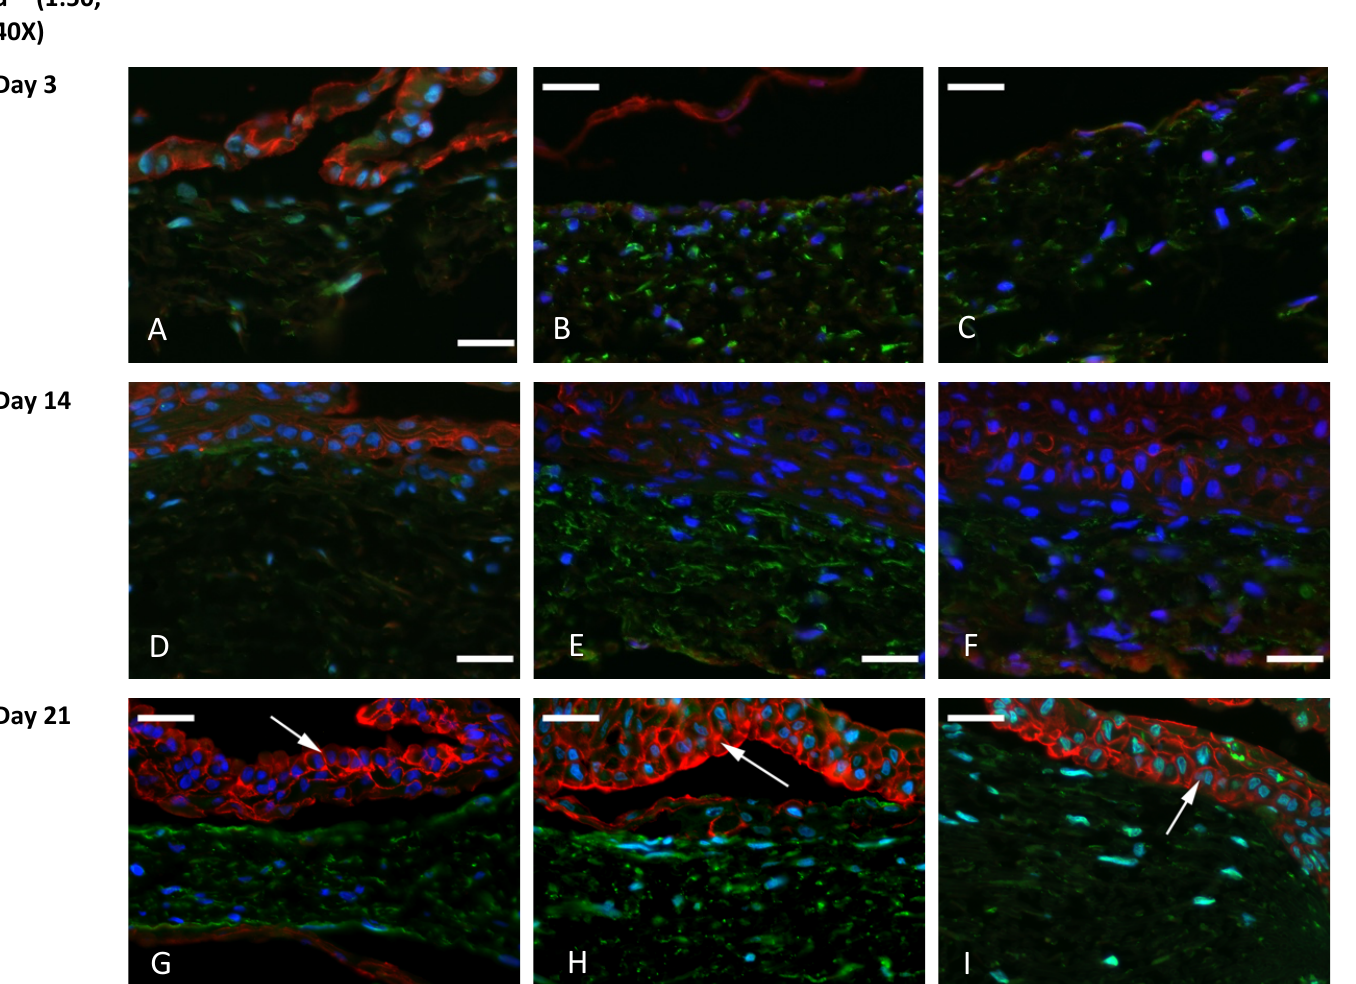
Figure 2. LocaKon and interacKons of dental cells as assessed by immunofluorescent staining . Immunofluorescent staining at Days 3 (A-C), 14 (D-F) and 21 (G-I) in NM (A, D & G), IGF-1 (B, E, H) and EMD (C, F & I). DAPI (blue) was used to counterstain all nuclei. VimenWn (green) labels hDM cells, while Ecad (red) labels pDE-CSs. Very close contact between the different layers was observed in all constructs (scale bar = 50μm). DisWnguished polarized structures are clearly visible in the D21 samples